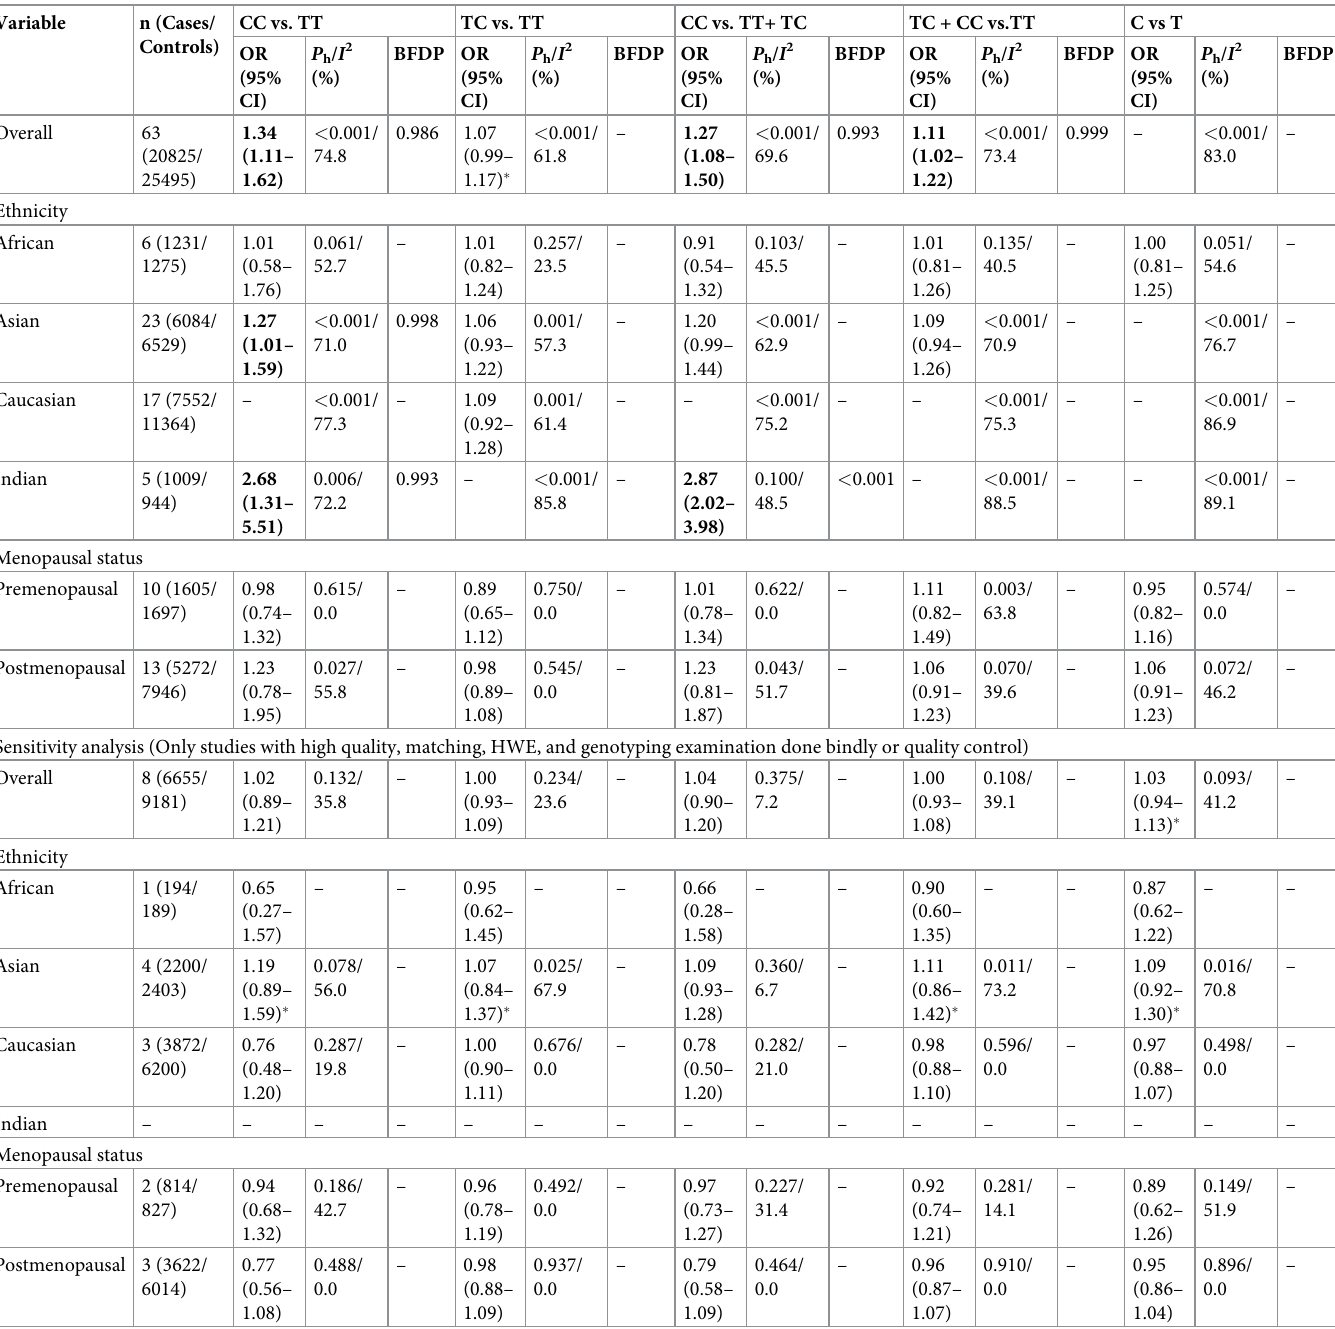
Table 2. Meta-analysis of the association of the CYP1A1 T3801C polymorphism with risk of BC. Variable n (Cases/ CC vs. Controls)